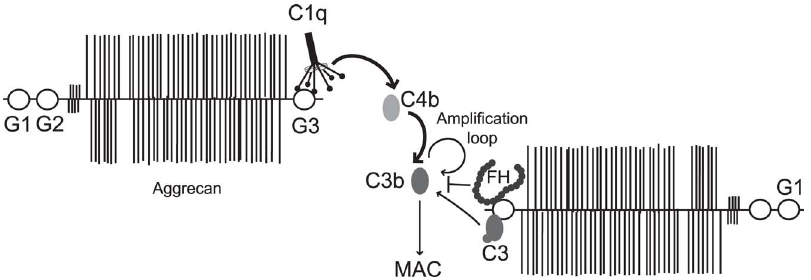
Figure 8. Schematic representation of interactions between aggrecan G3 domain and complement. C1-complex binds the aggrecan G3 domain via the globular heads of C1q, which leads to activation of the classical pathway and the deposition of C4b. Classical pathway C3-convertase is formed, which generates C3b, which is further enhanced by the alternative pathway acting as amplification loop. Furthermore, interaction of G3 with C3 leads to low degree activation of the alternative pathway. Deposited C3b is included in C3- and C5 convertases that finally lead to the formation of MAC. Complement factor FH also binds G3 and is suggested to attenuate the amount of deposited C3b and formed MAC.